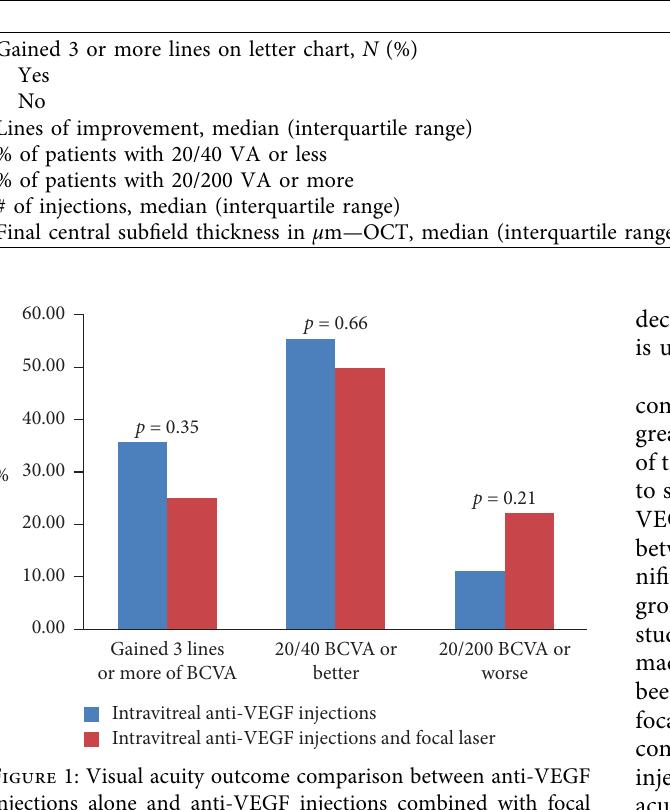
Table 2: Outcomes in BRVO-related ME: injections only vs. injections plus focal laser.